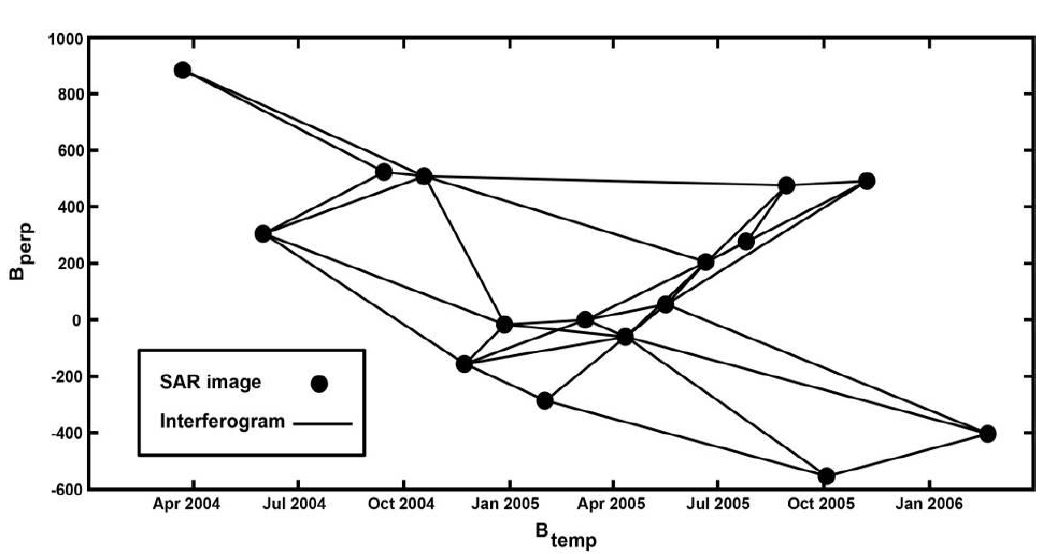
Figure 5. The Small Baseline (SBAS) network of selected interferograms used for the time-series analysis; horizontal and vertical axes represent the temporal and spatial baselines of selected pairs,